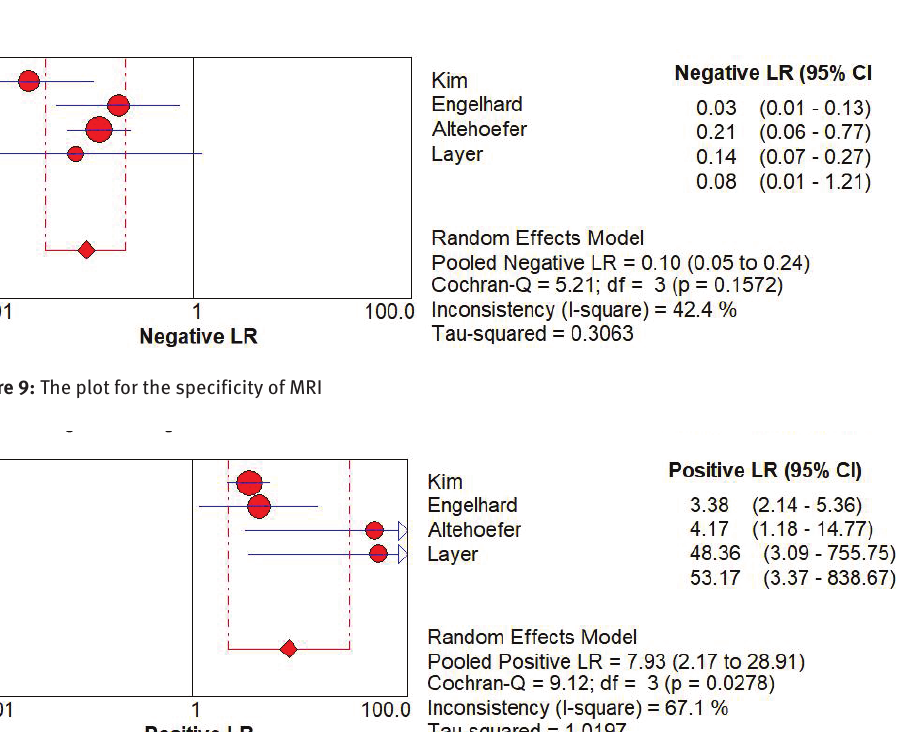
Figure 8: The SROC curve of MRI Figure 11: TThe SROC curve of BS